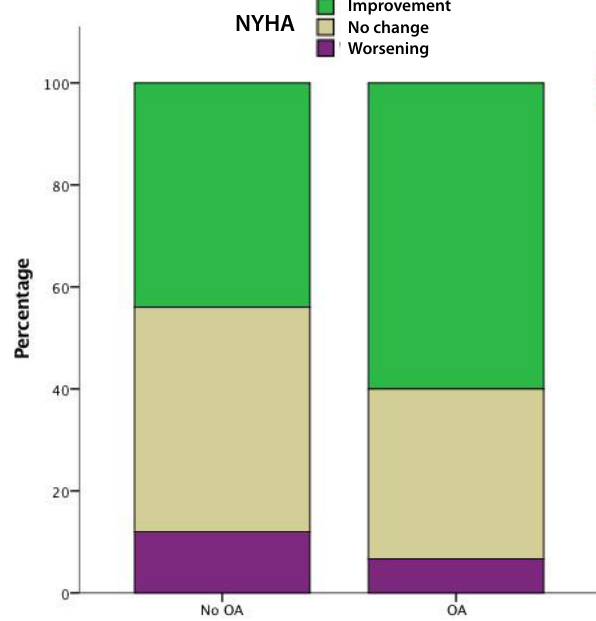
Fig. 3 – Change in New York Heart Association (NYHA) class at follow-up in patients with and without oral anticoagulation (OA) with > 21 mm prosthesis. Green=patients who improved their NYHA; brown=patients who reported no change in their NYHA; purple=patients who reported worsening of their